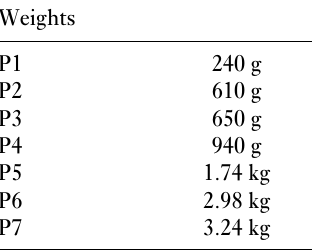
Figure 3 EMG amplifier and filters.